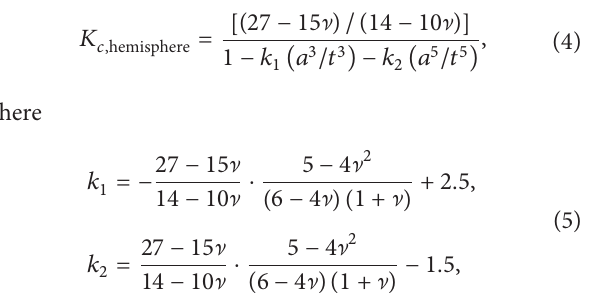
Figure 5: Exact-hemispherical corrosion